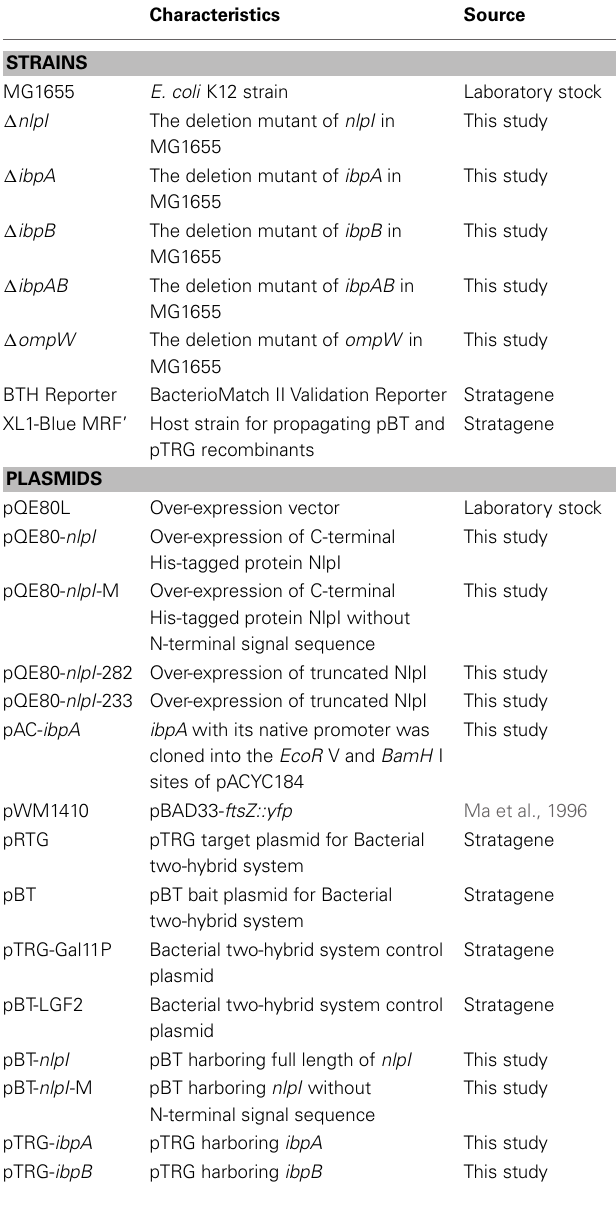
Table 1 | Bacterial strains and plasmids used in this